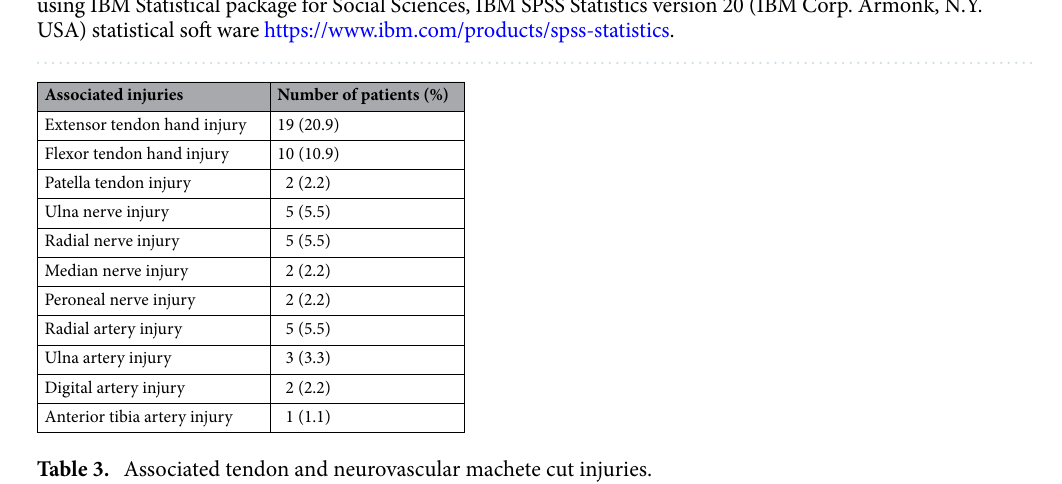
Table 3. Associated tendon and neurovascular machete cut